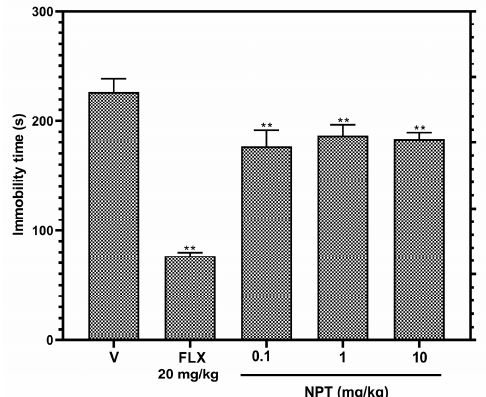
Figure 6. Antidepressant-like effects of NPT. Effects of NPT (0.1, 1 and 10 mg/kg p.o.) on immobility time were determined in the tail suspension proof. Fluoxetine (FLX) was used as the positive control. Bars represent mean values ( ± SEM) for the experimental group. n = 8, ** p < 0.05 compared to the vehicle group (indicated as